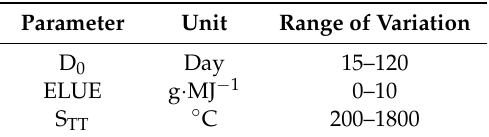
Table 3. Range of variation of calibrated parameters for test